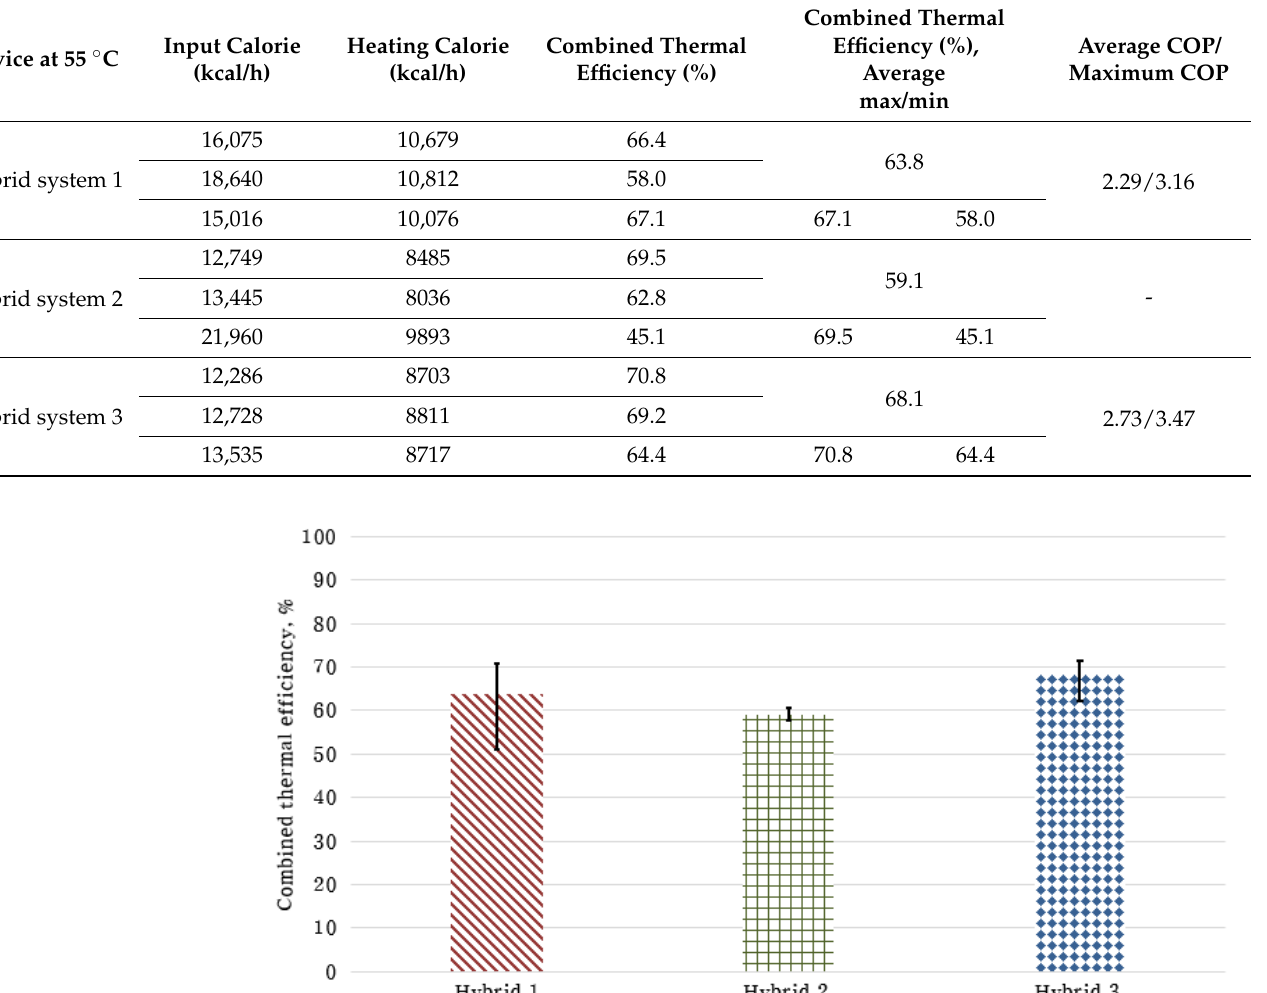
Table 5. Comparative analysis combined thermal efficiency.